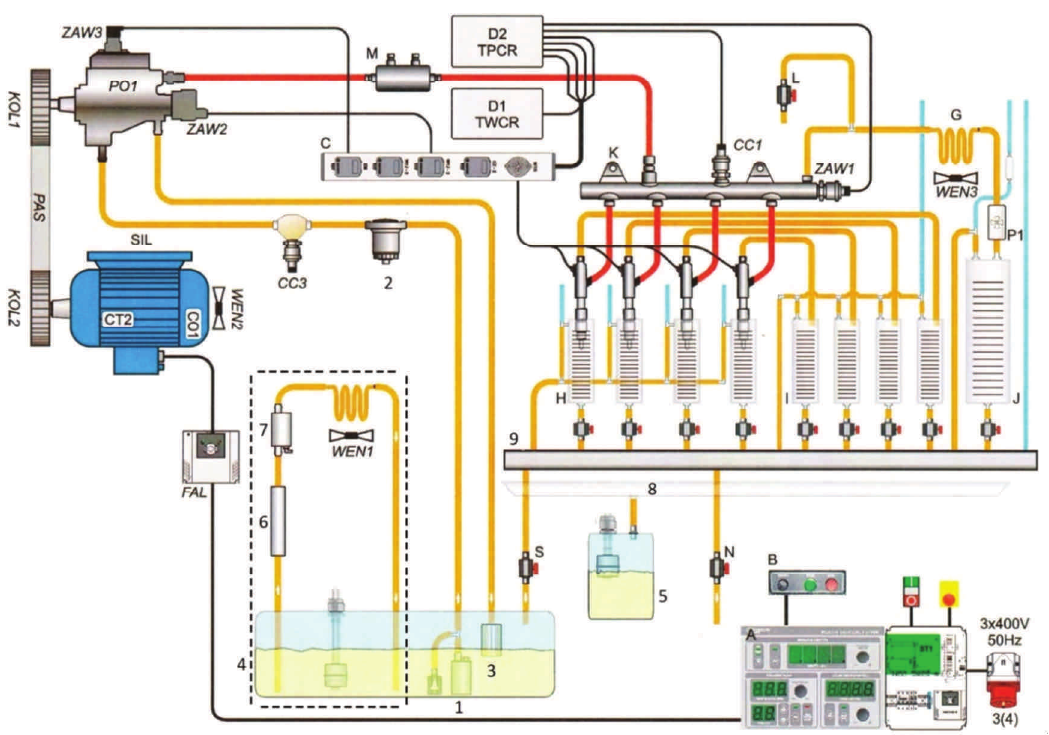
Fig. 3. Scheme of STPiW device